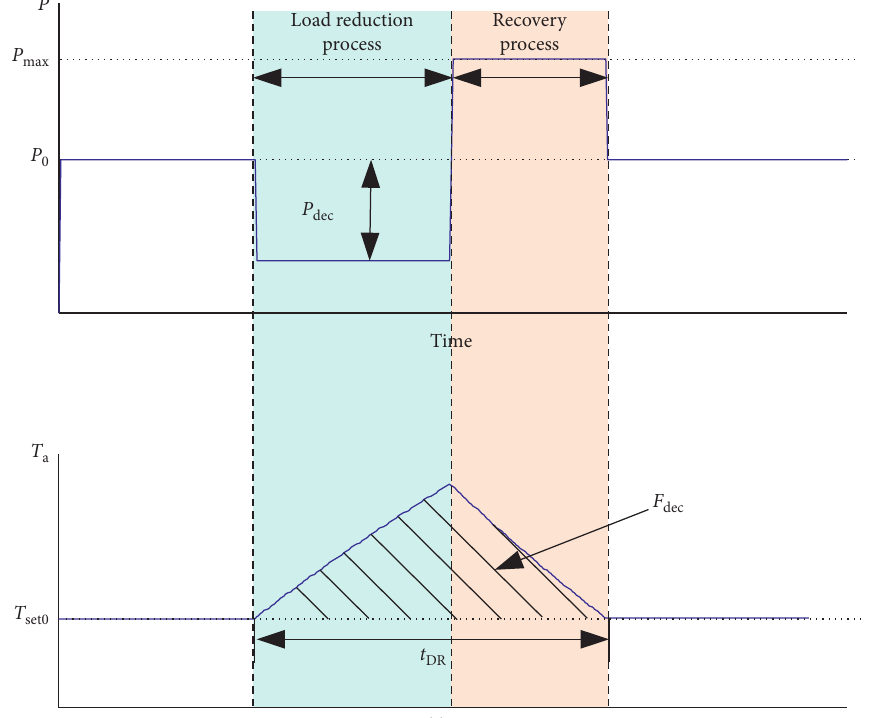
Figure 3: Example of air conditioning load control and reduction process and recovery